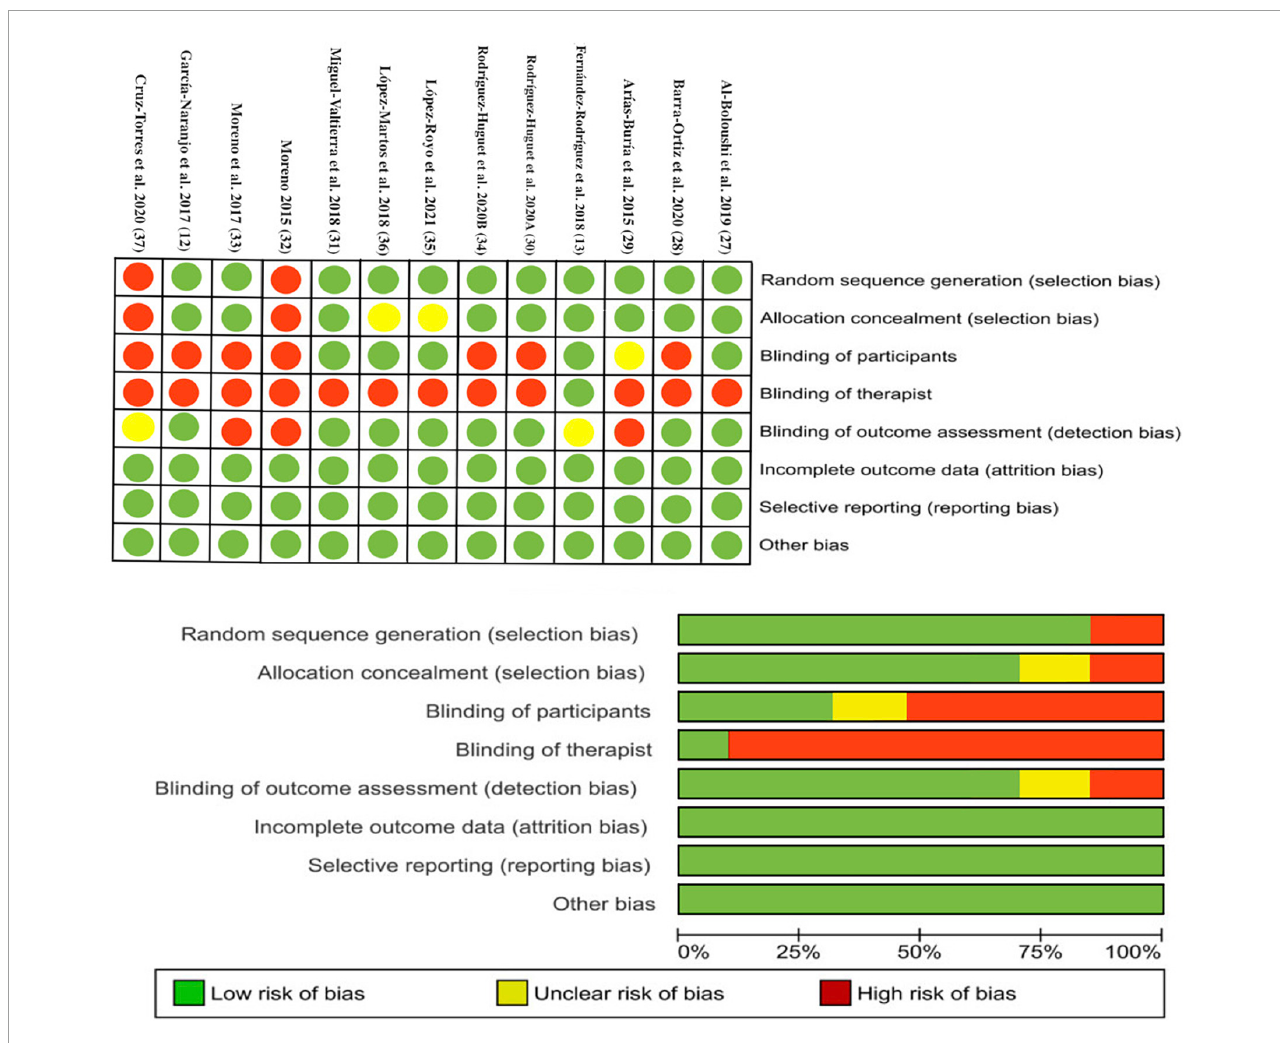
FIGURE2 Plots of risk of bias of the included